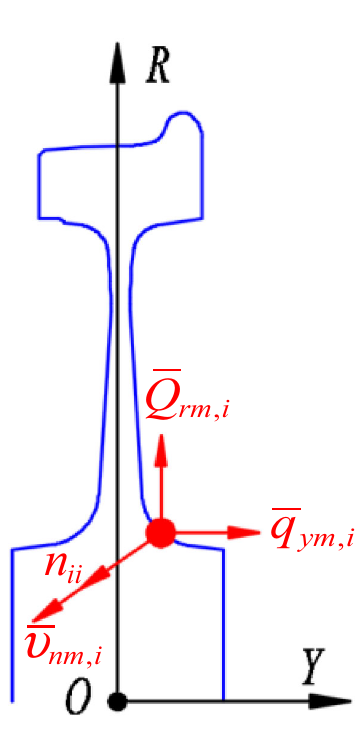
Fig. 2 Normal vibration